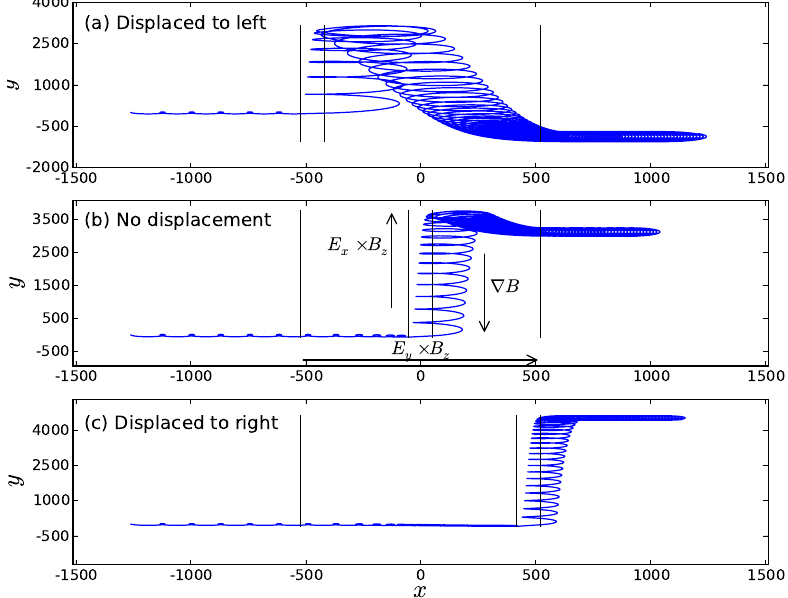
Fig. 4. Three electron trajectories in the xy plane for different displacements of the electric field profile. In all three cases the magnetic field variations occur between the two outer vertical lines. The electric field variations are bound by the two left-most lines in (a) , the centre two lines in (b) , and the two right-most lines in (c) . All other parameters are fixed. The drift directions are shown in (b) . The panels show that when the electric field is displaced upstream, i.e. (a) , the electron will drift in the negative ˆ y direction a lot more compared to when the displacement is downstream, i.e. (c)